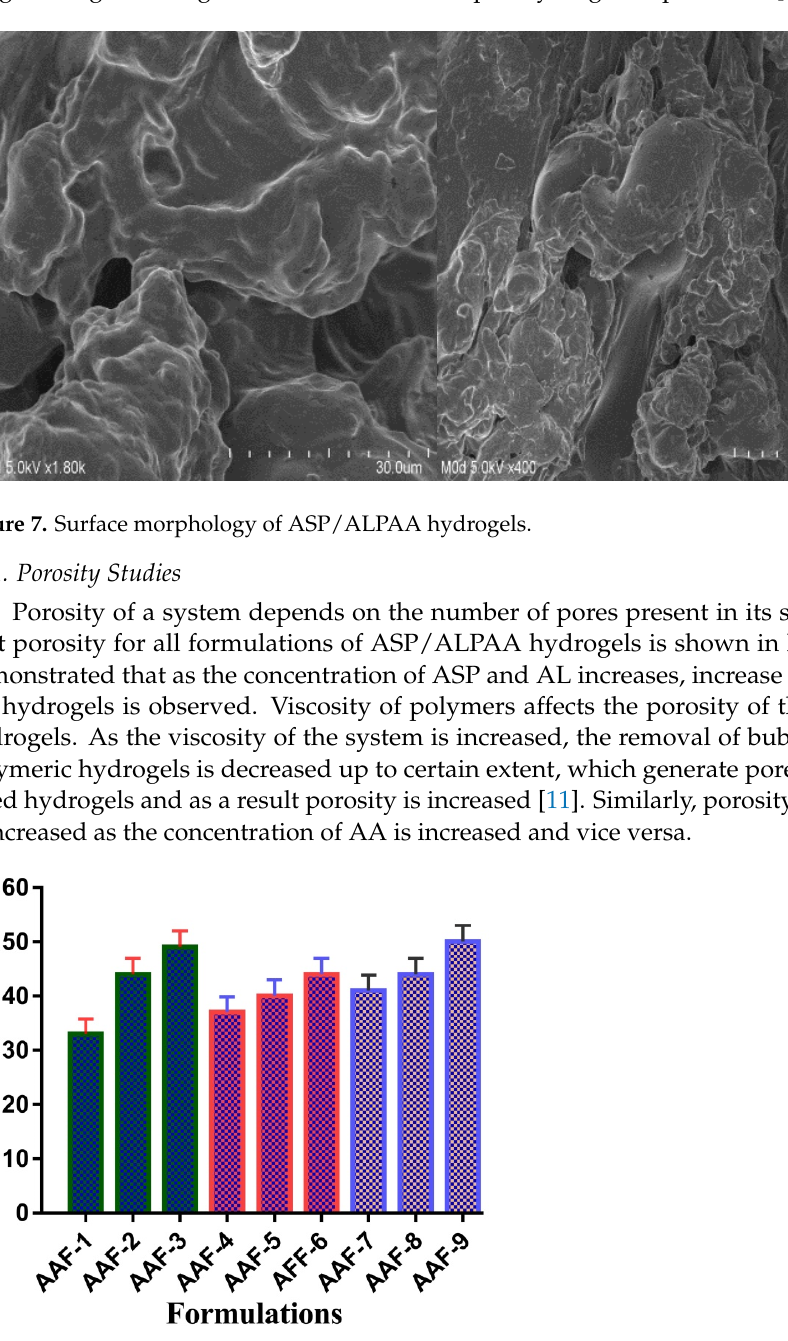
Figure 8. Percent porosity of ASP/ALPAA